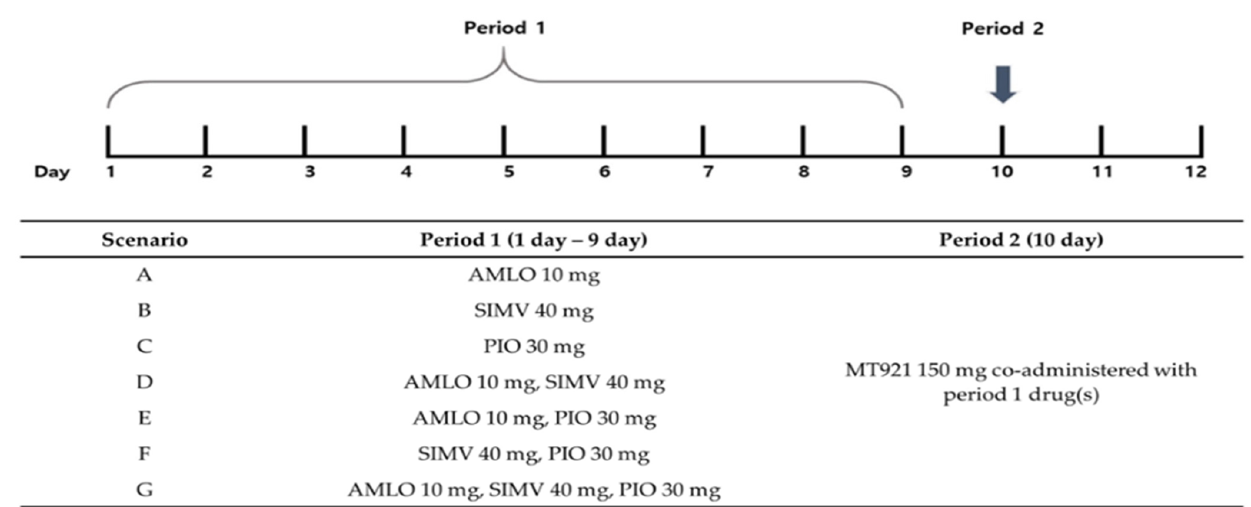
Figure 5. DDI scenario. During period 1, DDI drug(s) was administered as q.d., and MT921 was co-administered with DDI drug(s). AMLO, amlodipine; SIMV, simvastatin; PIO, pioglitazone.